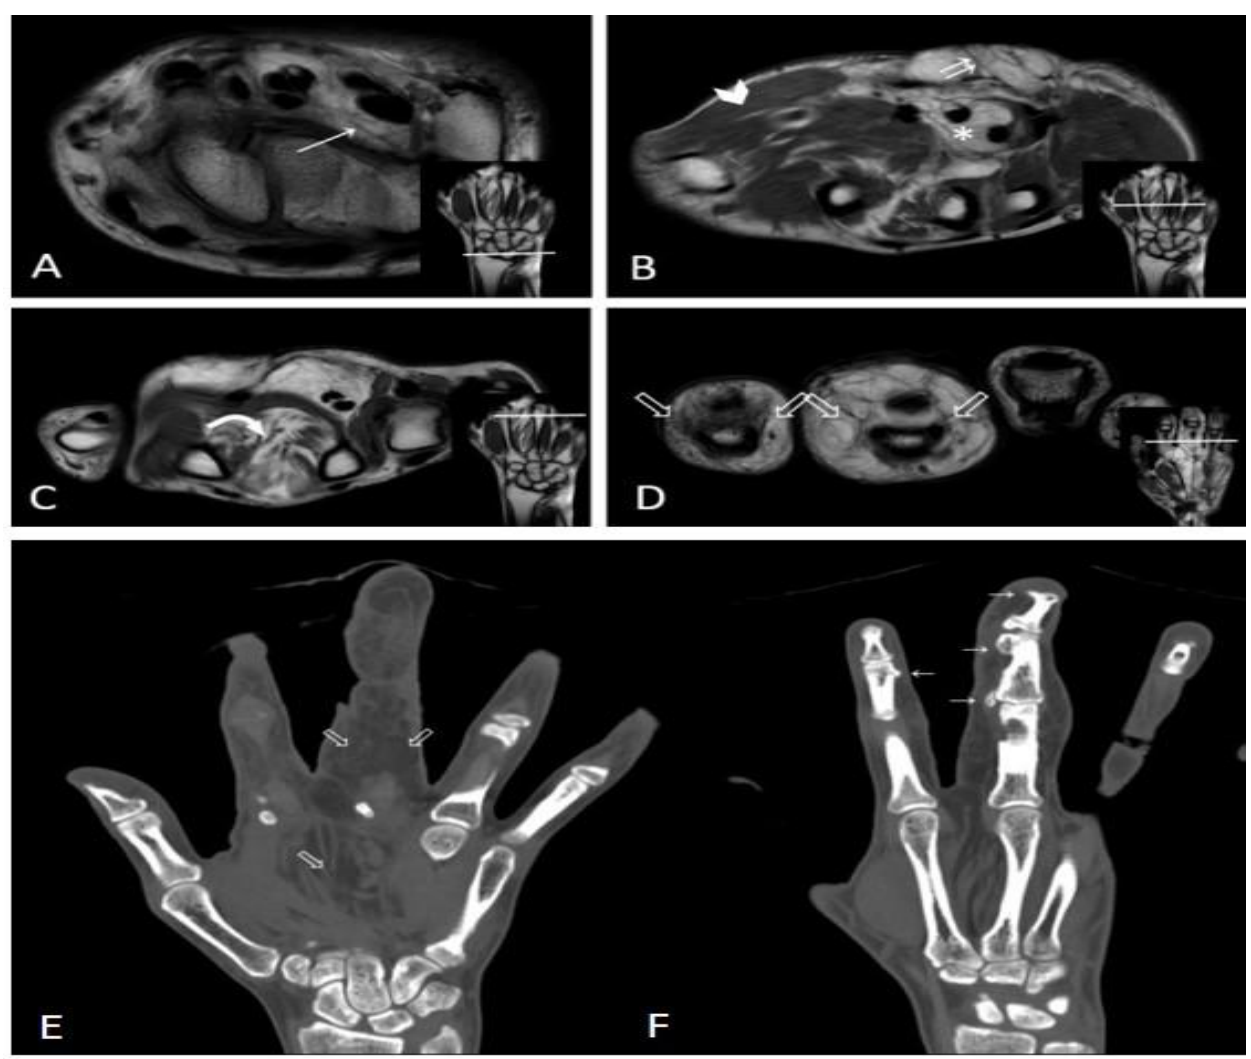
Figure 2: Magnetic resonance axial images of the hand in T1 weighted sequences. (A). Separation of the flexor tendons by fatty tissue is identified, observing fine hypointense lines distributed in the fatty tissue (arrow) that correspond to the median nerve. (B). Separation of the flexor tendons by fat tissue (asterisk). Note the distribution of the cutaneous branches of the median nerve infiltrated by fibroadipose tissue, conditioning separation of the nerve fibers (double arrow). Discrete atrophy with fatty replacement of the muscles (arrowhead). (C). Axial image at the distal metacarpal level. The lipofibromatous hamartoma follows the distribution of the fourth collateral branch of the median nerve between the second and third metacarpals, conditioning a mass effect and fatty infiltration with atrophy of the second lumbrical. (D). The lipofibromatous hamartoma is observed in the fourth to the collateral branches of the median nerve on the radial and ulnar sides of the index and middle fingers (hollow arrows). (E, F) Computed tomography of the lipofibromatous hamartoma of the median nerve with coronal reconstruction. (E). Infiltration of fatty tissue between the soft tissues (hollow arrow), at the level of the palm and on the index and middle fingers with distribution along the branches of the median nerve. (F). Exostoses (arrows) are also seen on the index and middle